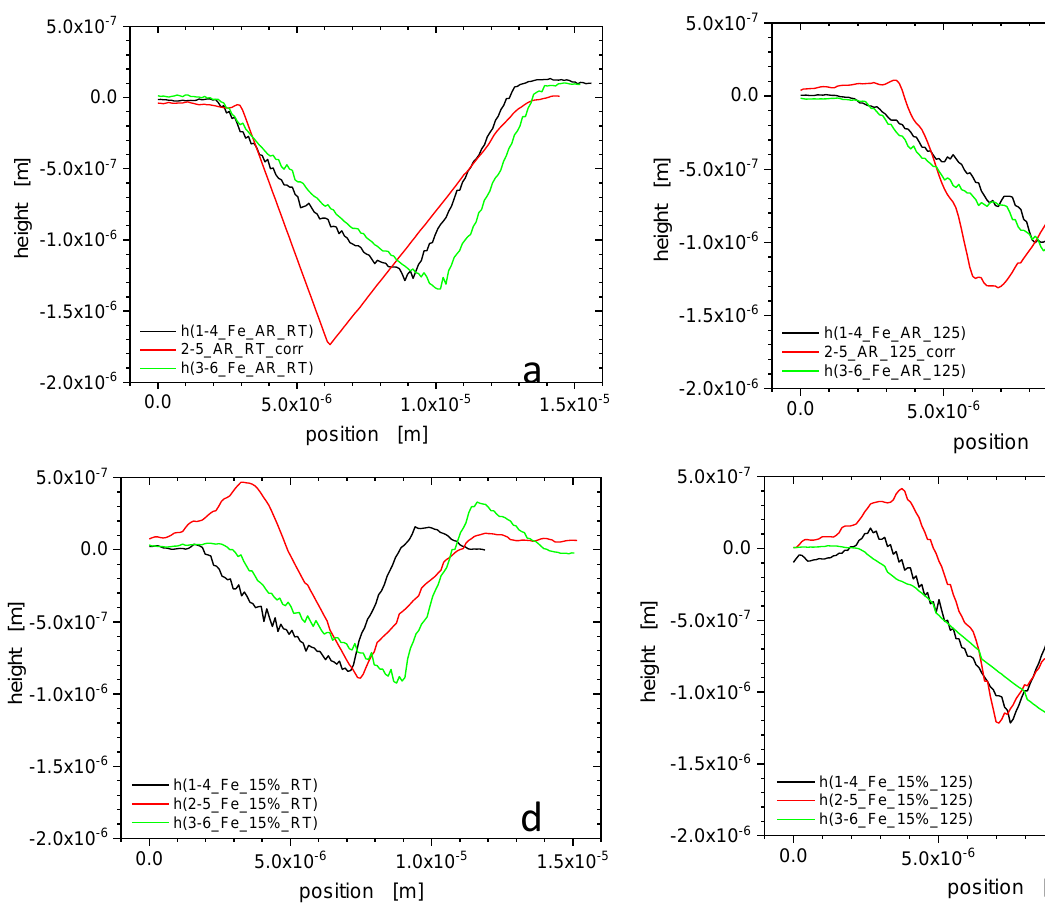
Figure 6. Cross-sectional height profiles from AFM images of Fe after nanoindentation: ( a ) Fe-AR-RT, ( b ) Fe-AR-125 ◦ C, ( c ) Fe-AR-300 ◦ C, ( d ) Fe-15%-RT, ( e ) Fe-15%-125 ◦ C, ( f ) Fe-15%-300 ◦ C, cf. previous figure. The 2–5 profiles of Figure 6a–c have been corrected for zero reference height away from the indent. From the AFM images and the resulting cross-sectional profiles, one notes that the formation of pile-ups in the non-deformed state of the material is relatively weak as compared to the significant piling-up observed in the pre-deformed state of the material. Pre-deformation enhances the pile-up propensity, which affects the apparent nanoindentation hardness.